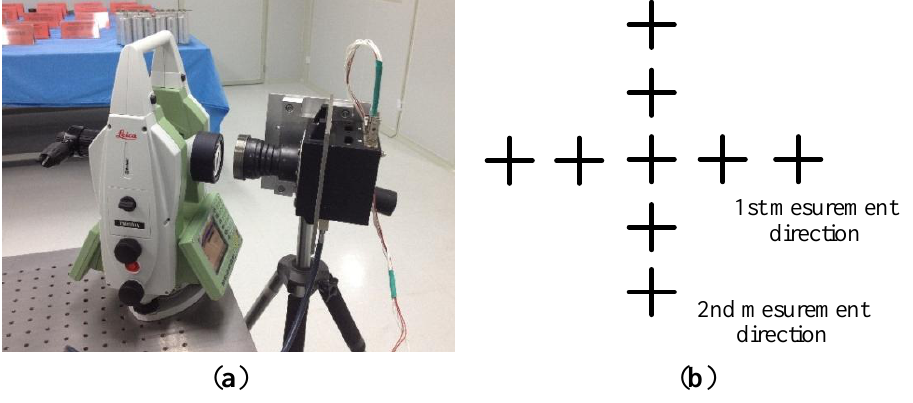
Figure 13. ( a ) Calibration experiment device; ( b ) Imaging method sketch